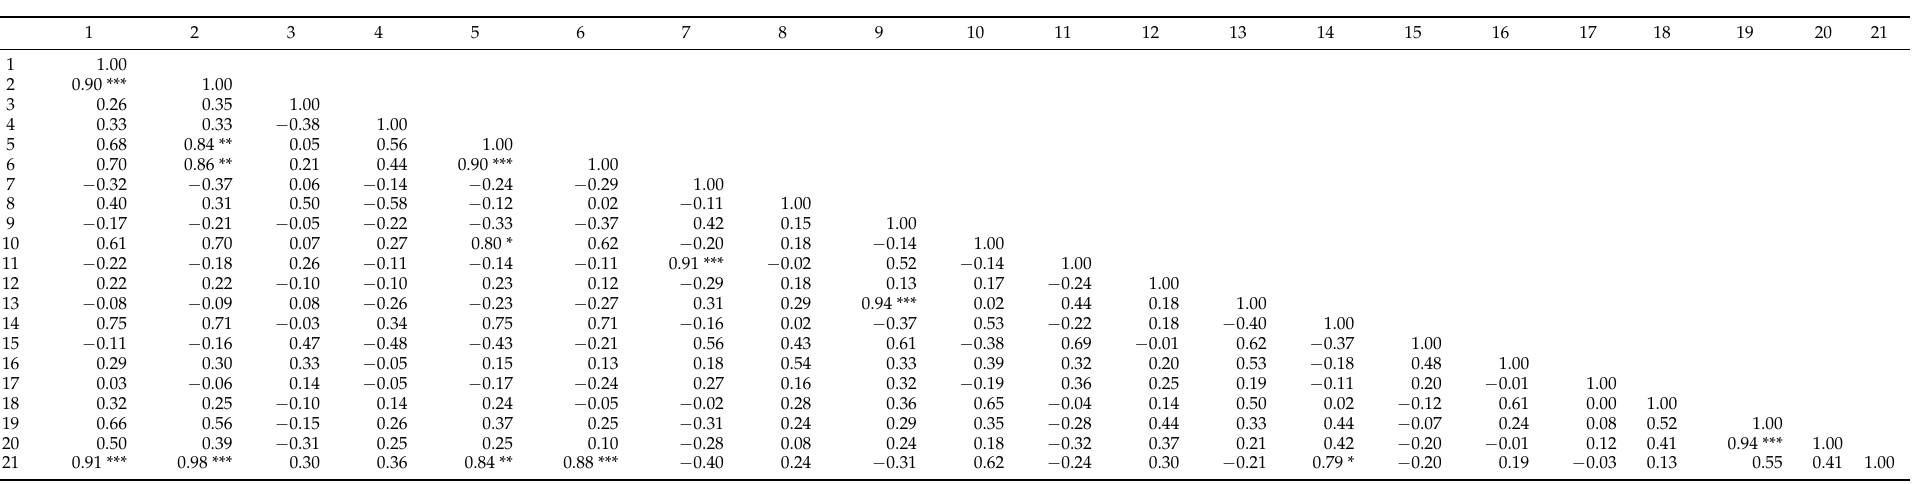
Table 8. Correlation analysis applied on the contents of individual polyphenols, TPC, RSA, and TAC in the analyzed grape samples a